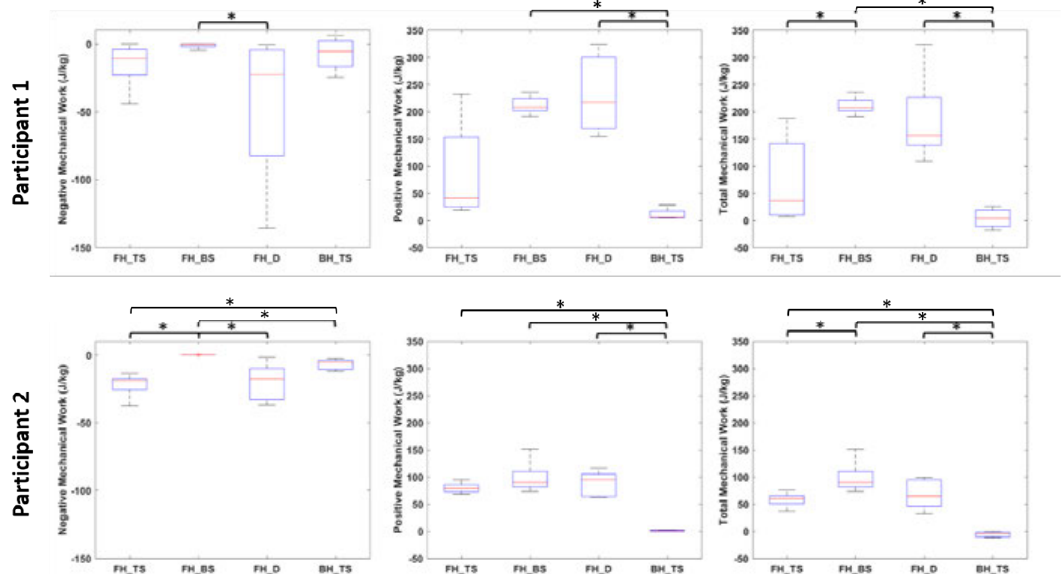
Figure 4 . Boxplot of the negative, positive and total mechanical works during the strike phase for both participants during the four activities (5 trials by boxplot). * indicates a significant difference between the